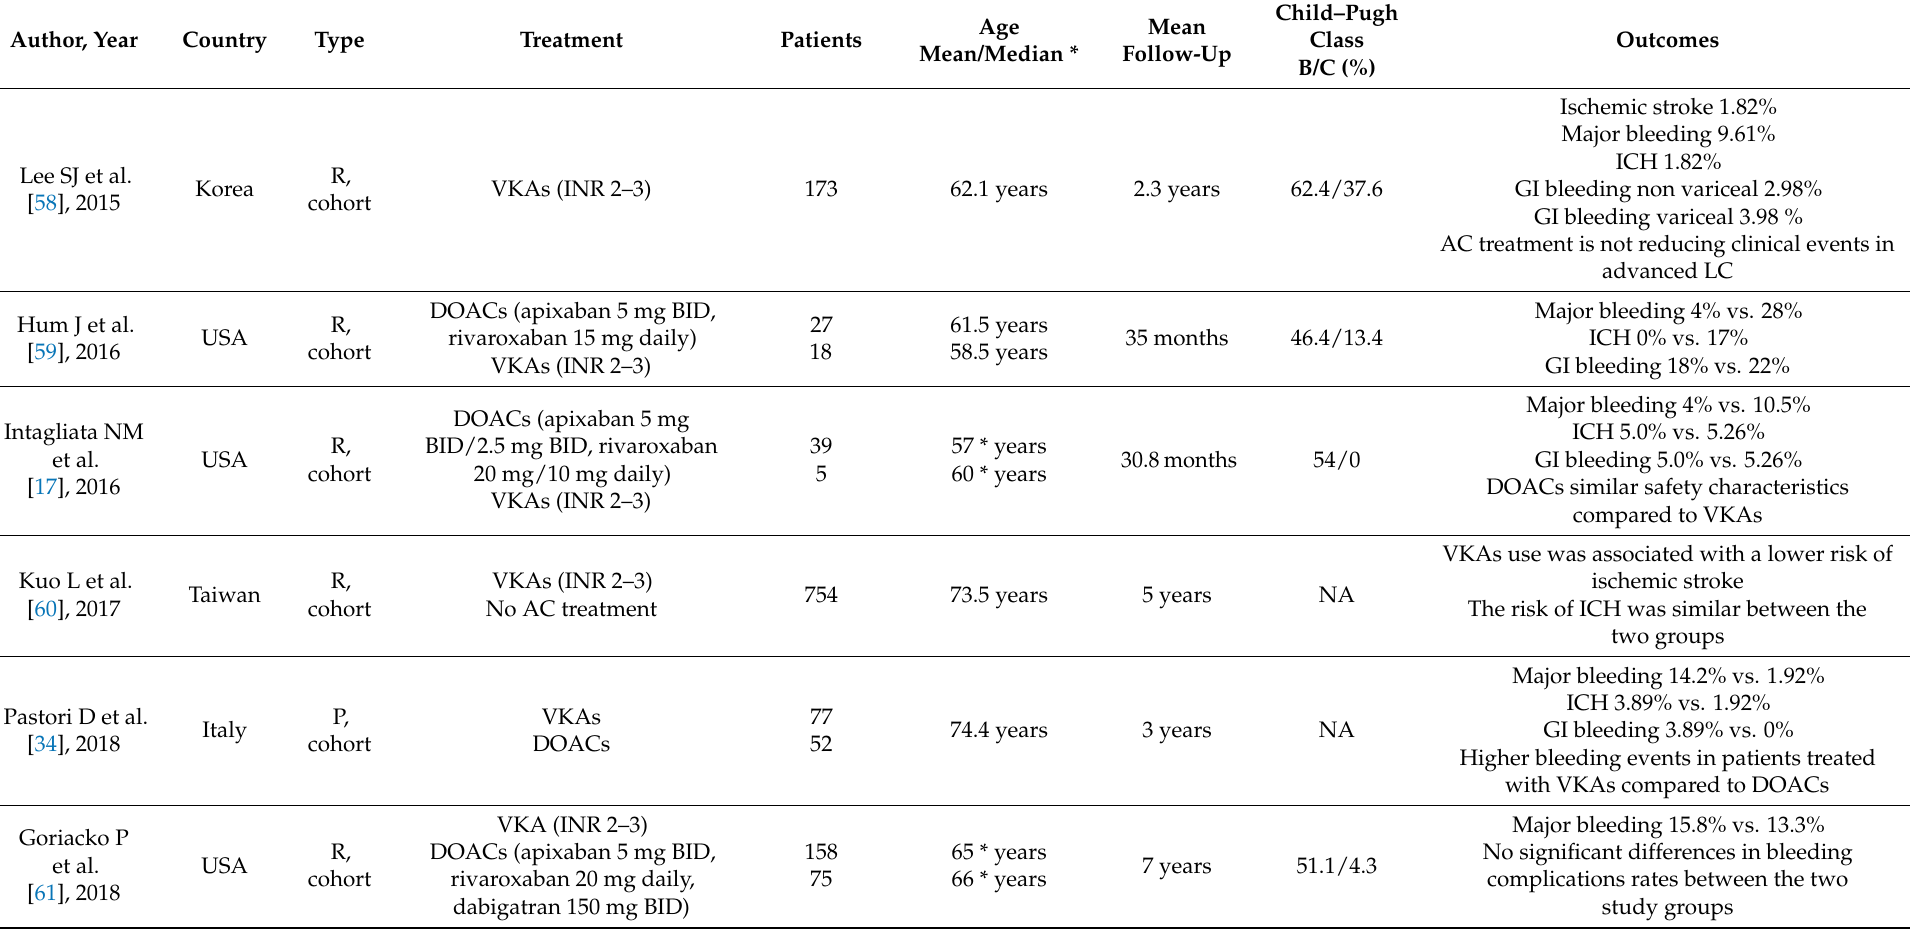
Table 1. Anticoagulant treatment in patients with decompensated liver cirrhosis and atrial